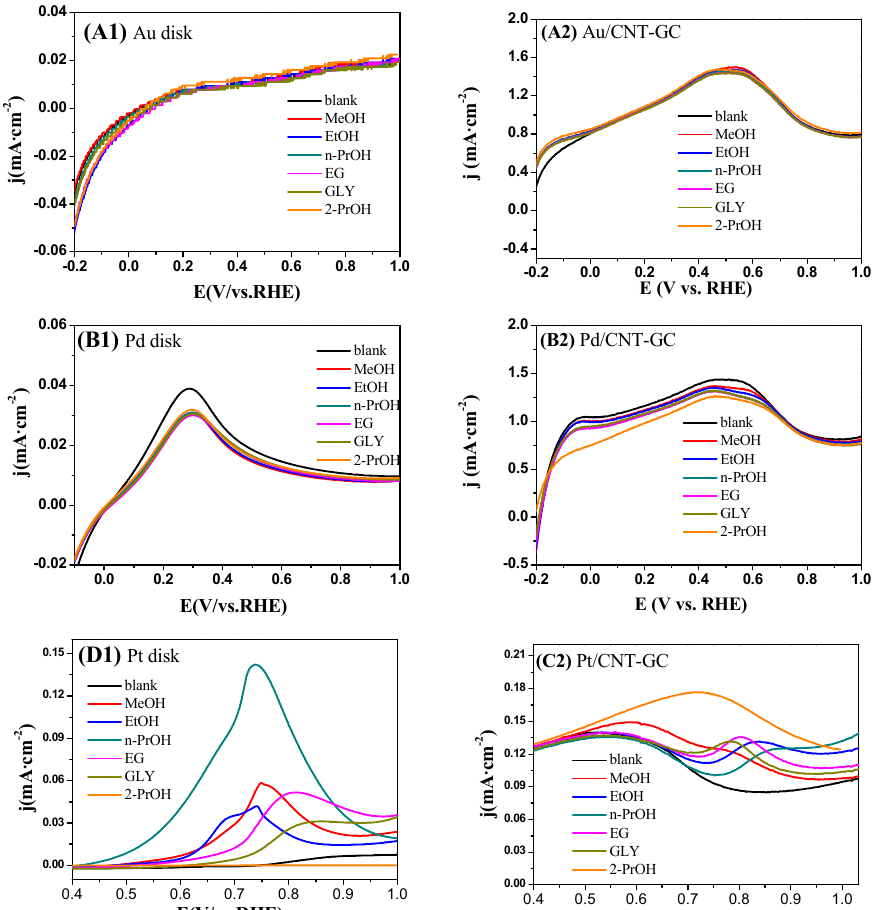
Figure 6. Voltammetry curves of alcohol electro-oxidation over different electrodes in 0.1 M HClO 4 solution.